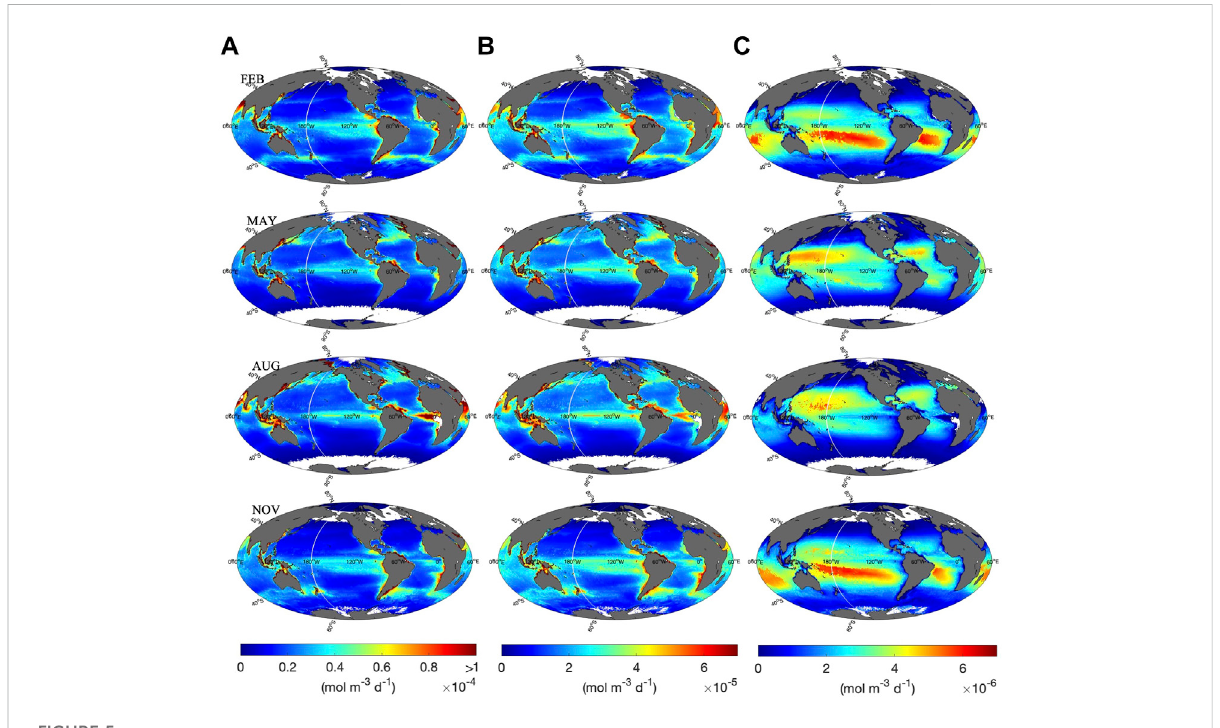
FIGURE 5 Calculated H 2 O 2 photoproduction rates at (A) 0 m, (B) 1 m, and (C) 20 m in February, May, August and November. Note the difference in scale between (A – C) . White indicates no